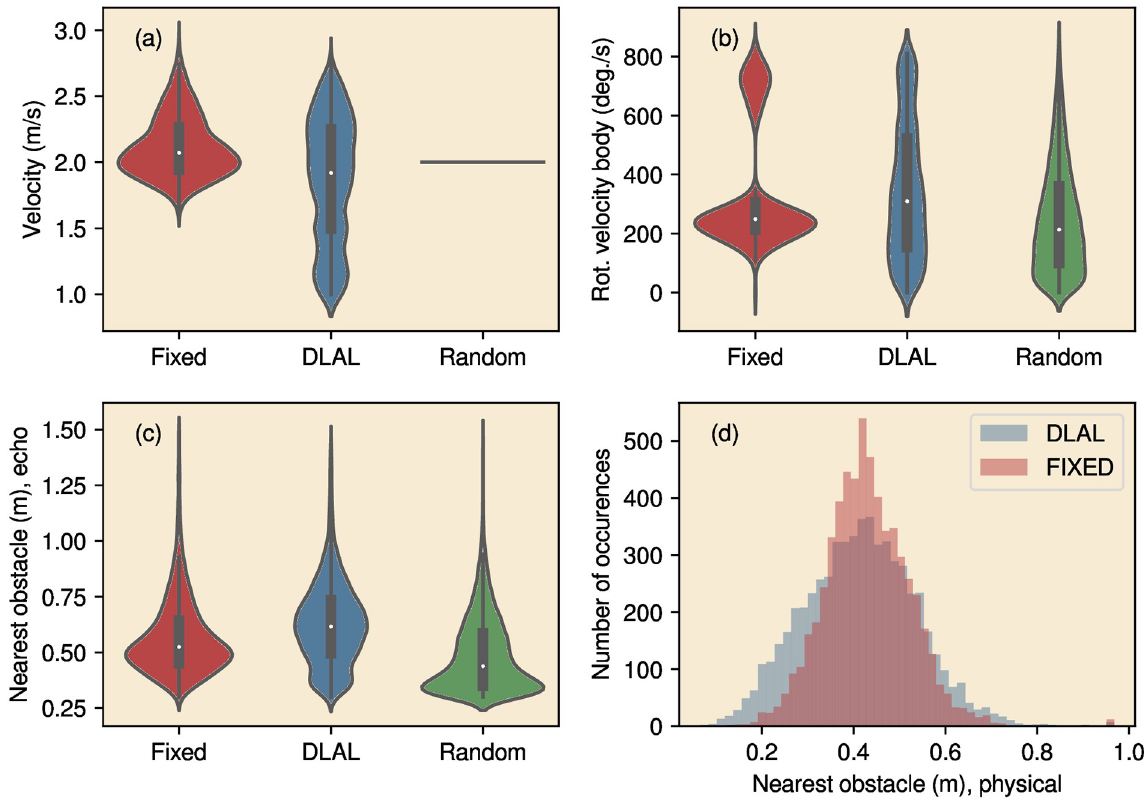
Fig 5. Descriptive statistics of the behavior of the robot in the arena, for the three strategies (Fixed Head Strategy, DLAL Strategy and Random Walk). (a) Violin plots of the velocity of the robot, (b) Violin plots of the rotational velocity, (c) violin plots of the distance to the nearest obstacle (as determined by the sonar), (d) distribution of the distance to the nearest obstacle (as determined by the Vive tracking